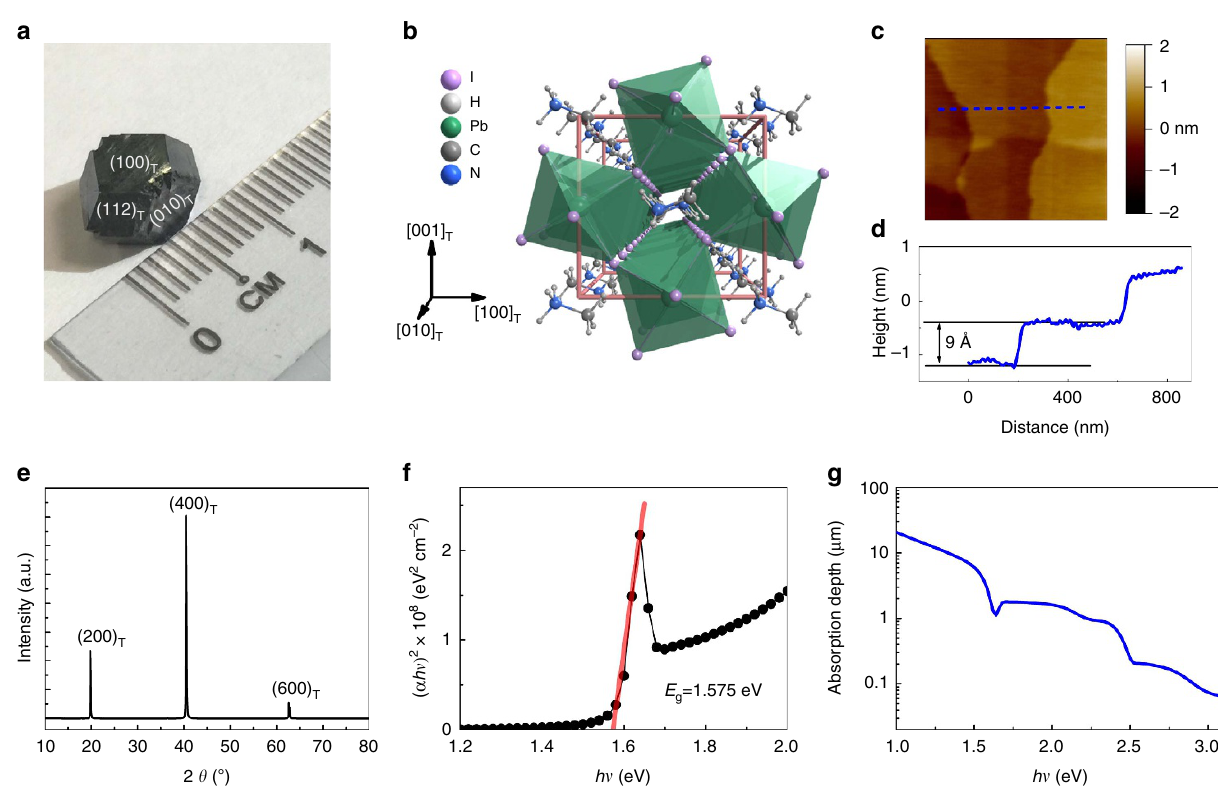
Figure 1 | Basic properties of the MAPbI 3 single crystals. ( a ) Photograph of a MAPbI 3 single crystal used in this study. ( b ) Perspective view of the unit cell of tetragonal MAPbI 3 . ( c ) Typical topography of the single crystal obtained by AFM, showing smooth surface with unit-cell steps. The scan size is 1 (cid:2) 1 m m. ( d ) Height profile along the blue dash line denoted in c . ( e ) X-ray diffraction pattern of the crystal, which only shows tetragonal ( l 00) type peaks, indicating the high quality of the single crystal. ( f ) Direct-transition tauc plot according to the absorption coefficient of the crystal, from which a direct band gap of 1.575eV is extracted. The red solid line is the linear fit. ( g ) The penetration depth deduced from the absorption